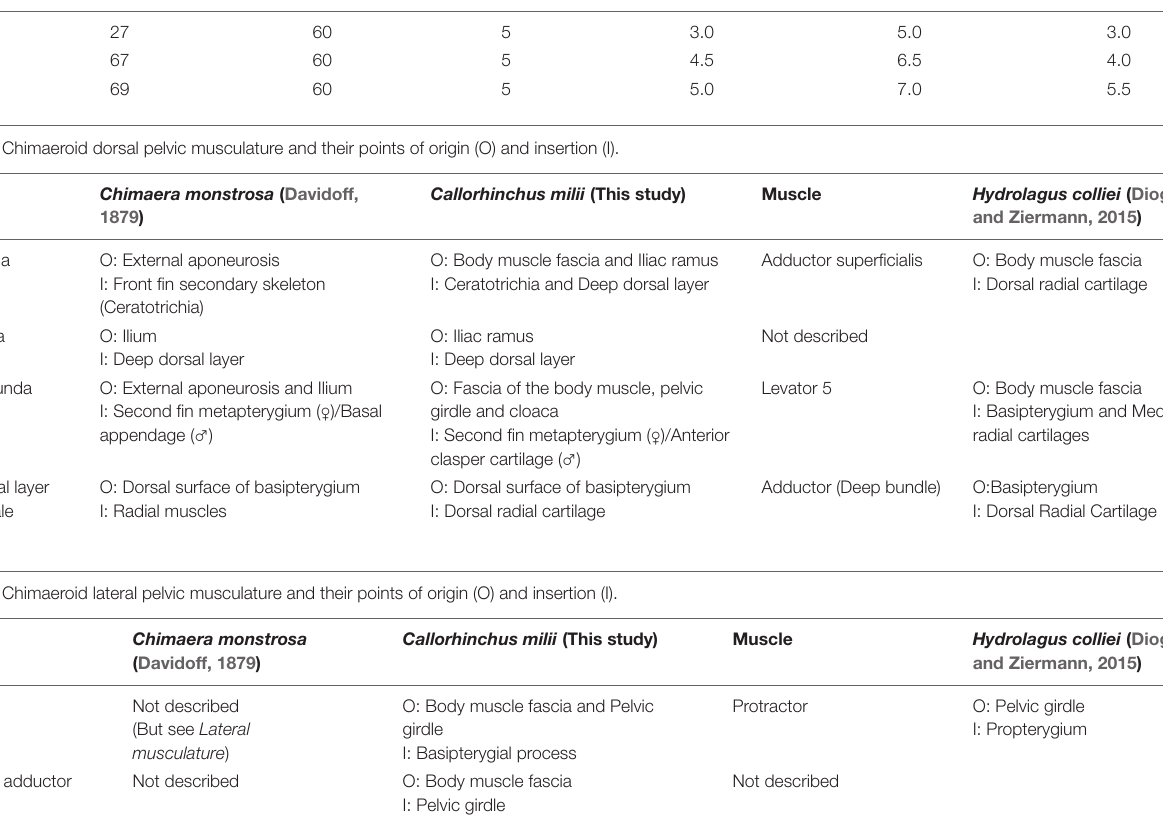
TABLE 1 | Staining duration and imaging parameters of embryonic specimens. Stage